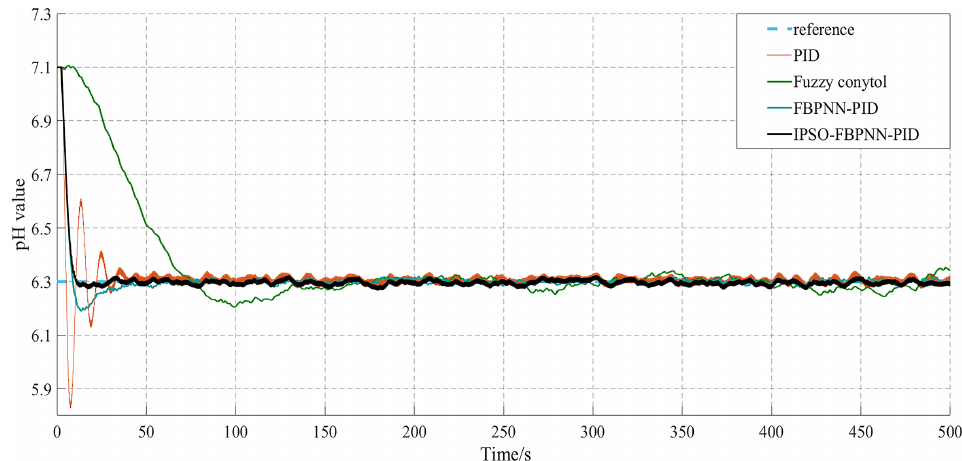
Figure 17. Comparative analysis of different control algorithms when regulating pH from 7.1 to 6.3.